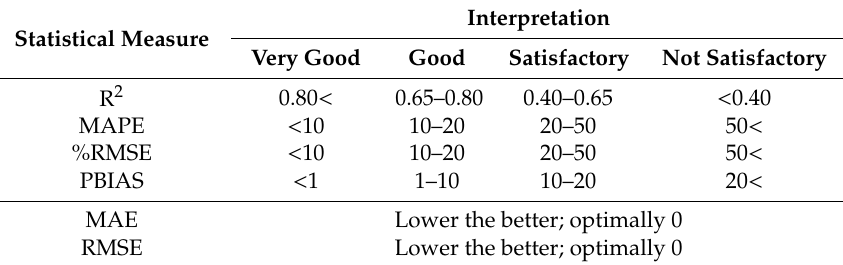
Table 1. Interpretation of statistical measures used for evaluating uncertainties (thresholds are based on [54,55]).